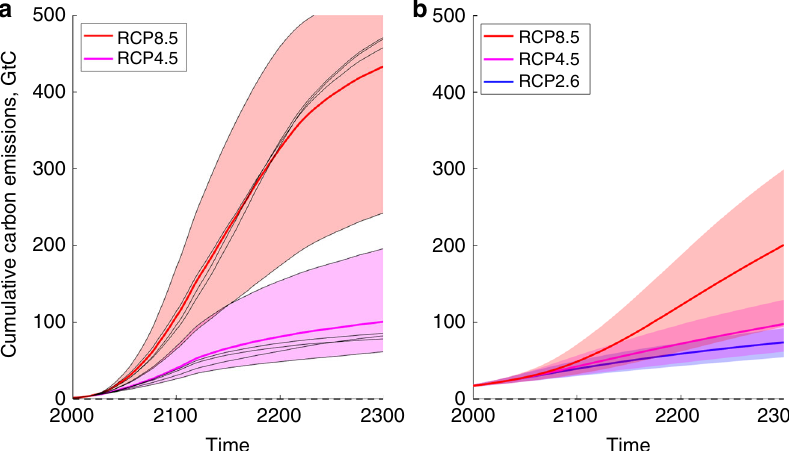
Fig. 1 Cumulative carbon emissions from thawing land permafrost simulated using specialised land surface models. CO 2 component of cumulative emissions of carbon from thawing land permafrost, obtained from a SiBCASA and b JULES LSMs forced by multiple climate models (GCMs) under a range of climate scenarios out to 2300. Thick lines: multi-GCM means; shaded areas: multi-GCM spread between the lowest and the highest values; thin black lines: SiBCASA runs with individual GCMs. Horizontal black dashed lines: legacy zero permafrost emissions currently assumed in IAMs. Units: GtC. Source data are provided as a Source Data fi